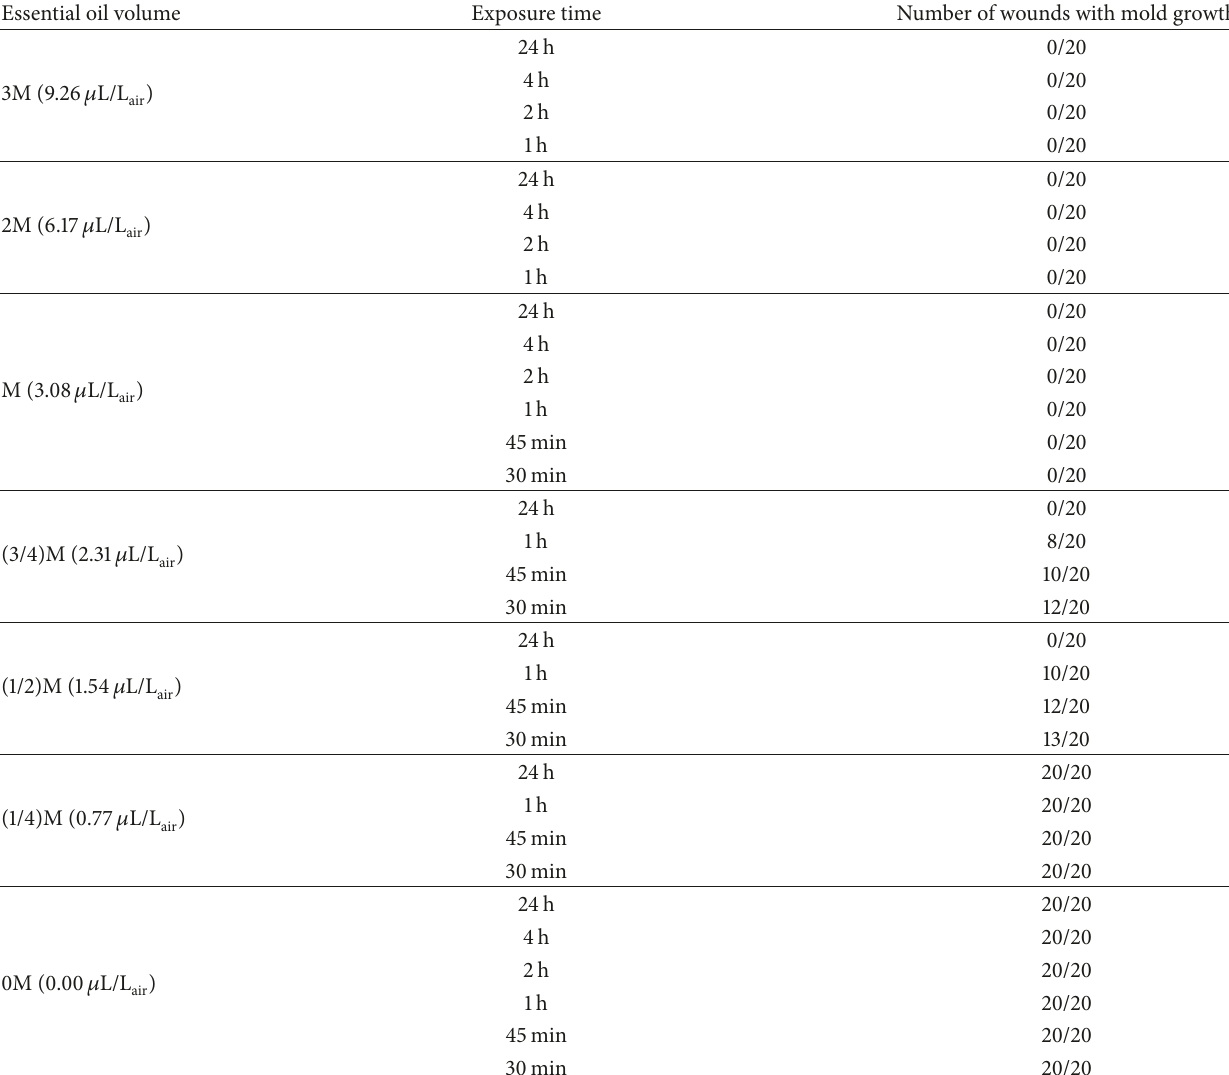
Table 2: Number of wounds (inoculated with Aspergillus niger ) on tomatoes that presented mold growth after 10 d of incubation with mustard essential oil in vapor phase at selected concentrations and periods of